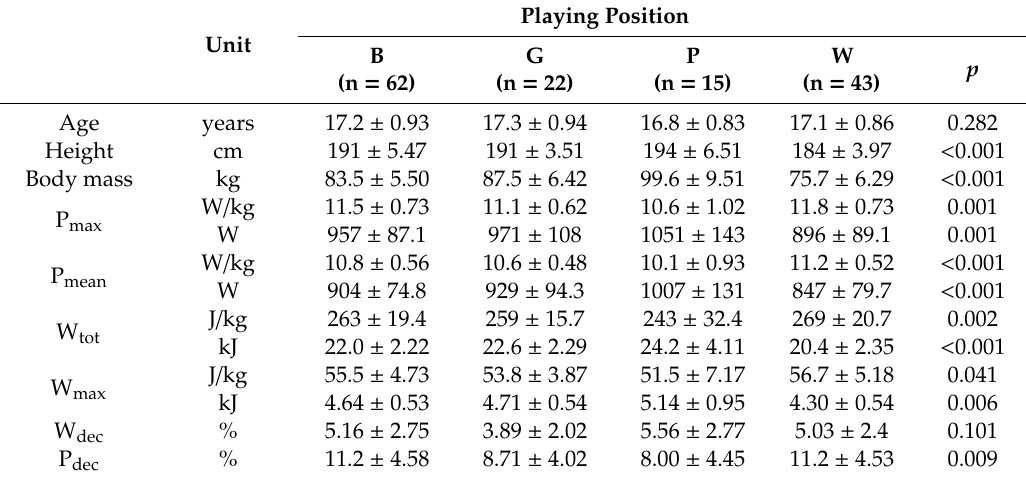
Table 2. Repeated sprint ability (RSA) test normative values with regard to playing position.